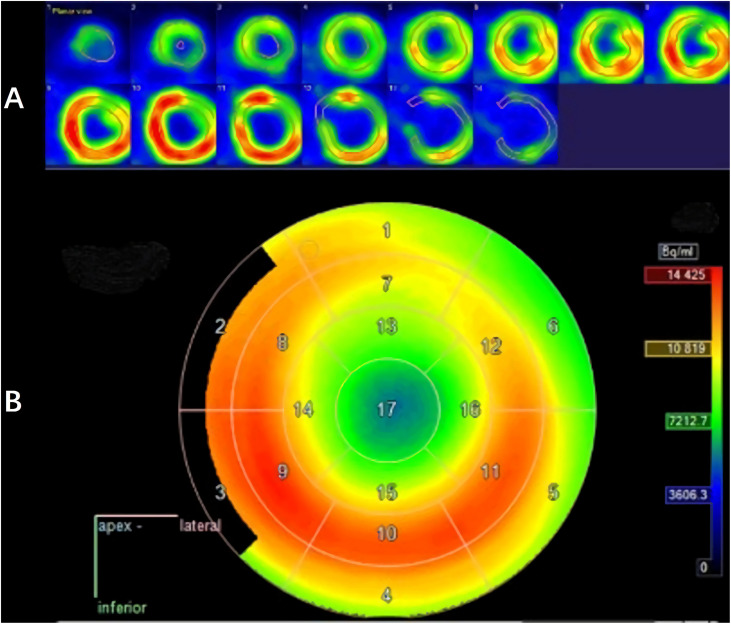
Left myocardium segmentation (A) and polar map (B).